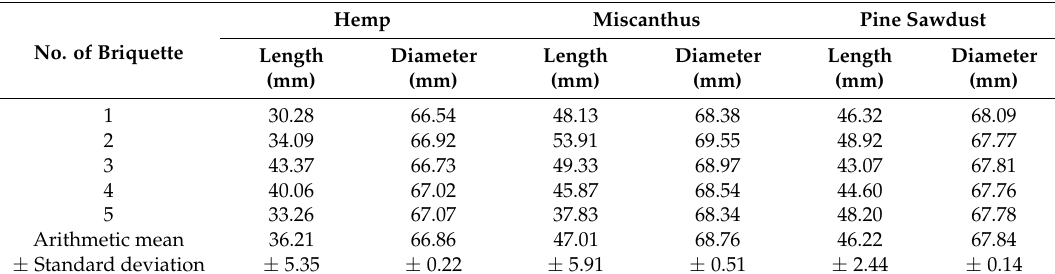
Table 2. The length and diameter of selected briquettes.